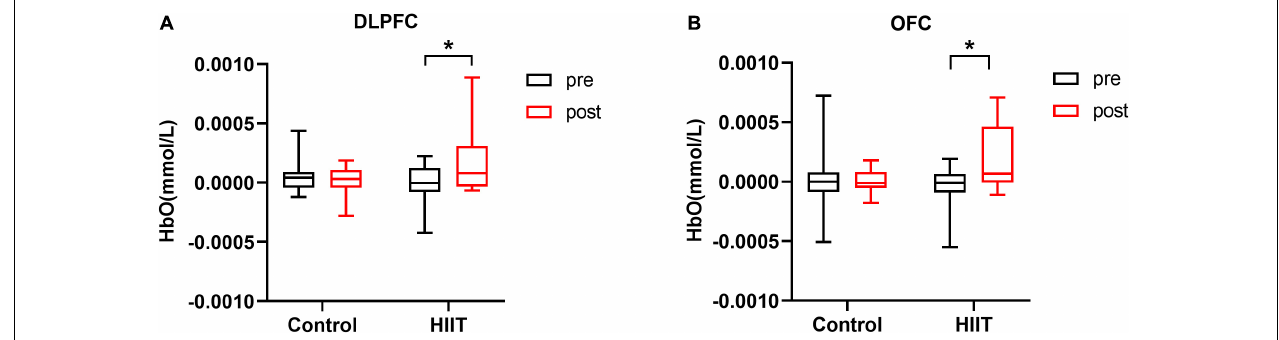
FIGURE 3 | (A) Mean oxygenated hemoglobin concentration in the left DLPFC in the pre-training and post-training periods of the control and HIIT groups. (B) Mean oxygenated hemoglobin concentration in the left OFC in the pre-training and post-training periods of the control and HIIT groups. Error bars represent standard deviations. * p <